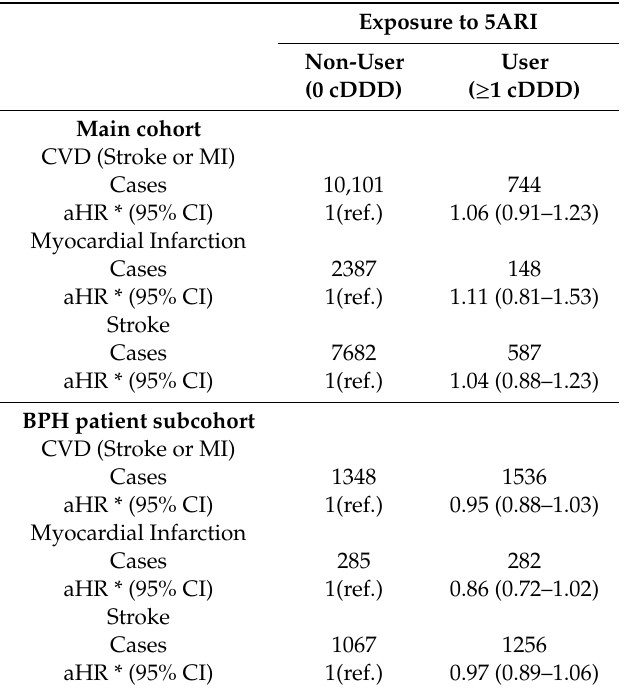
Table 2. Hazard ratios of 5ARI users vs.